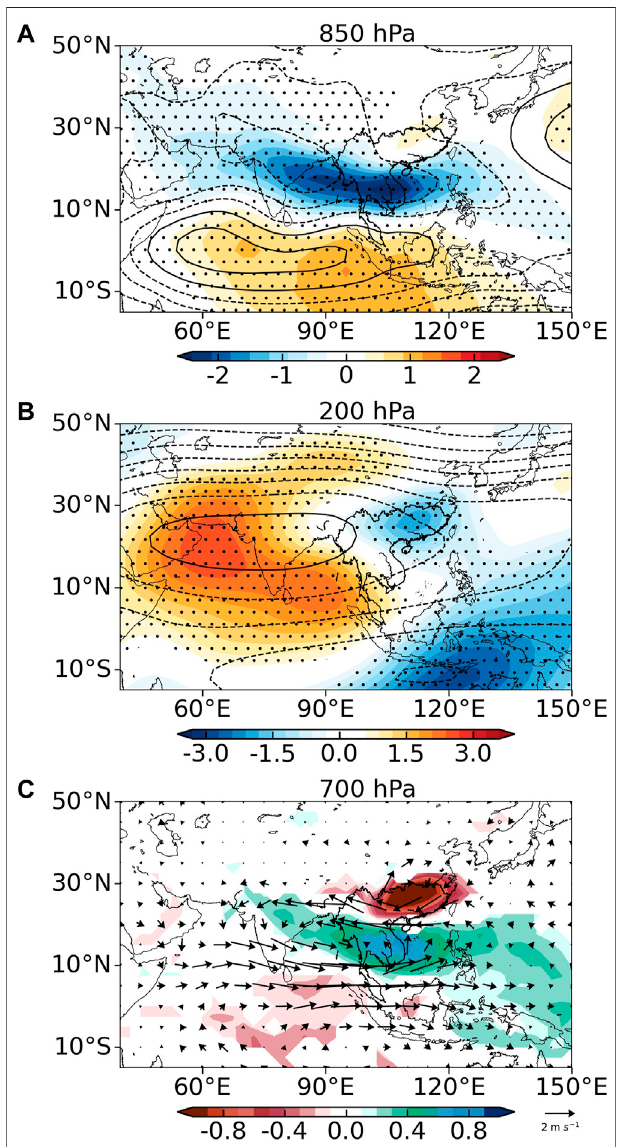
FIGURE 2 | Composite stream function (contours; units: 10 6 m 2 s − 1 ) and corresponding anomalies relative to the climatological mean (shading) associated with extreme precipitation at (A) 850 hPa and (B) 200 hPa. Contours aredrawnat intervals of3and 10for (A , B) , respectively. (C) is the composite 700-hPa speci fi c humidity anomalies (shading, units: g kg − 1 ) and horizontal wind anomalies (arrows, units: m s − 1 ). Stippling in (A , B) and shading in (C) indicate composite values that are statistically signi fi cant at the 90% con fi dence level.